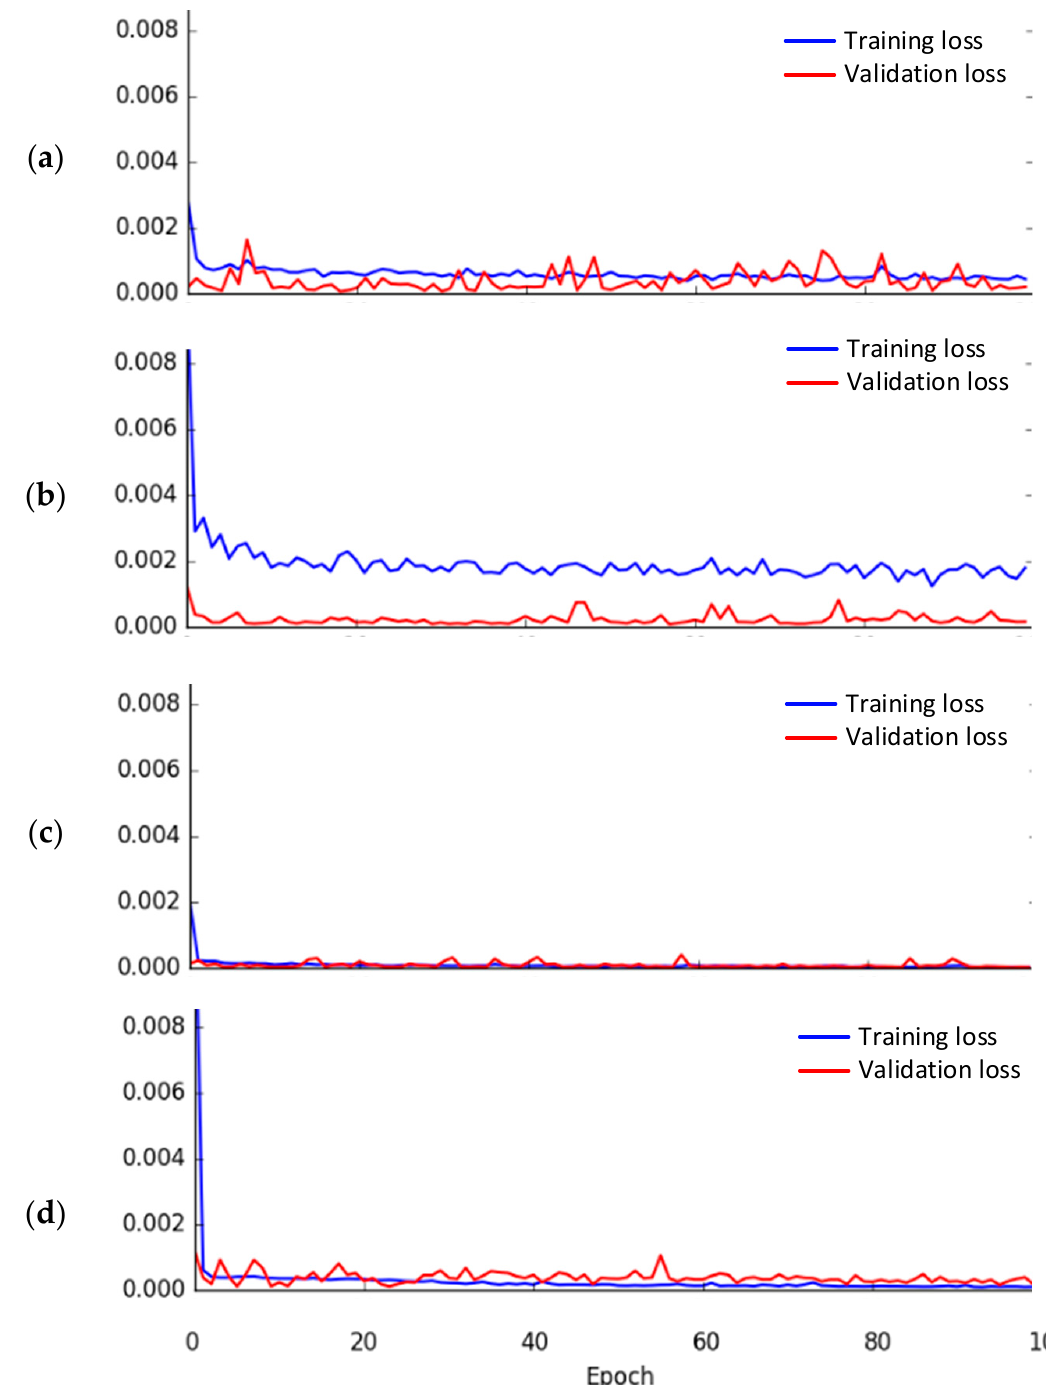
Figure 9. The model loss of RSRP after 2 s of prediction: ( a ) MLP, ( b ) CNN, ( c ) RNN, ( d ) LSTM.